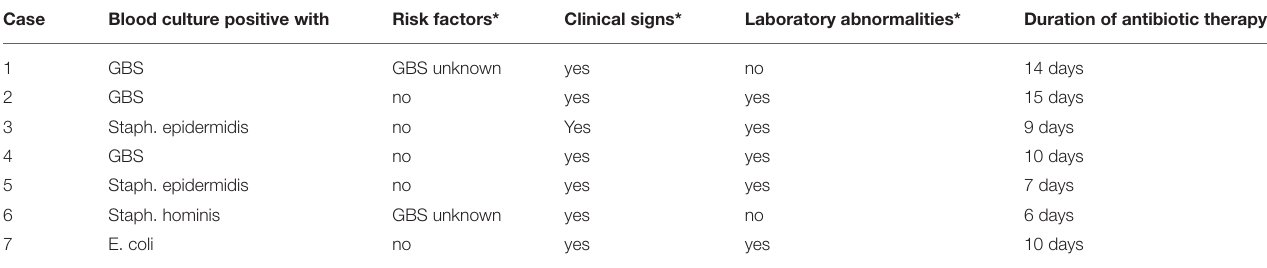
TABLE 3 | Characteristics of neonates at start of antibiotic therapy with culture-proven early-onset sepsis. Case Blood culture positive